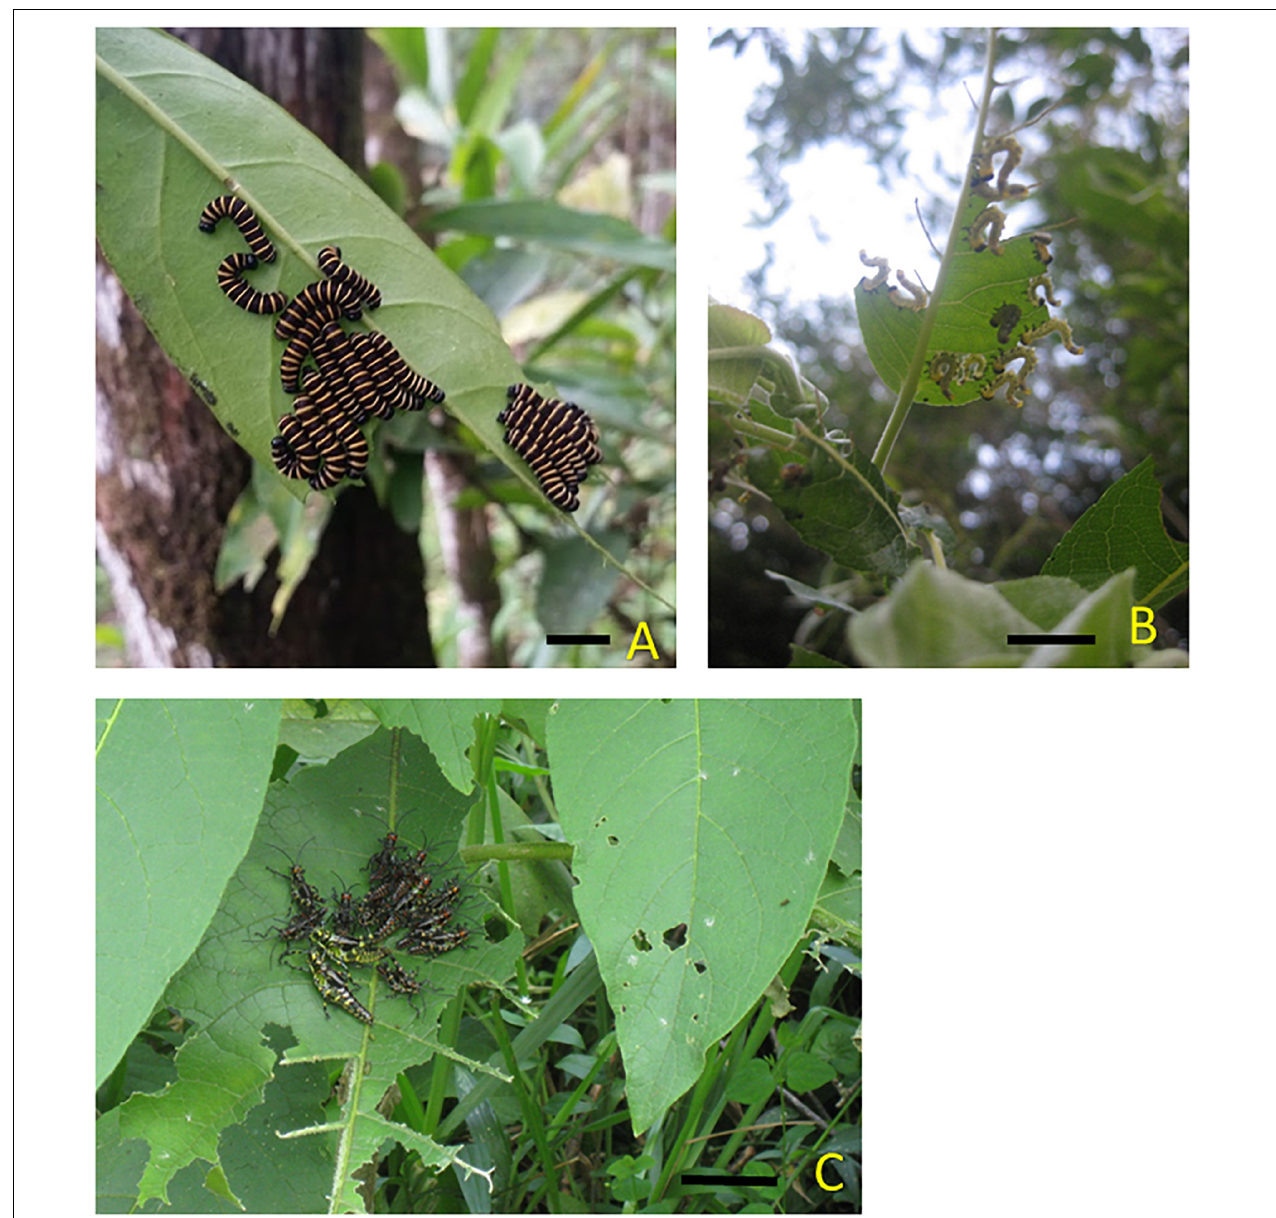
FIGURE 4 | Cooperation against predators (top-down pressures): (A) aposematic larvae of Methona confusa (Ithomiini) in secondary vegetation in cloud forest, Ecuador—photo credit Janeth Renteria, (B) collective defensive head-waving by Nematus spp., sawflies (Tenthredinidae) in boreal forest Québec, Canada, and (C) nymphs of Chromacris psittacus in secondary vegetation in cloud forest, Ecuador. Black bar in each panel indicates 1